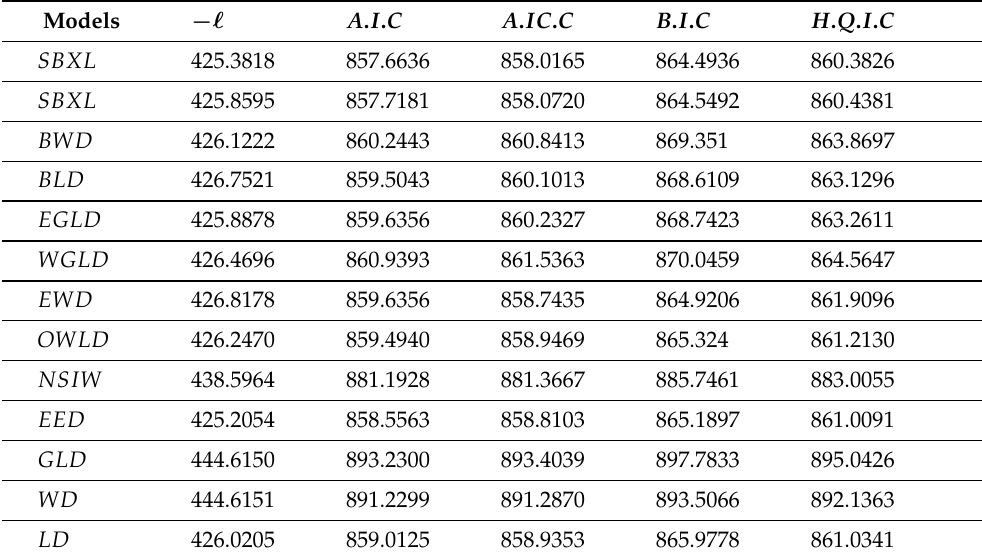
Table 28. Comparison of data set V fitting via information criterion of SBXL and